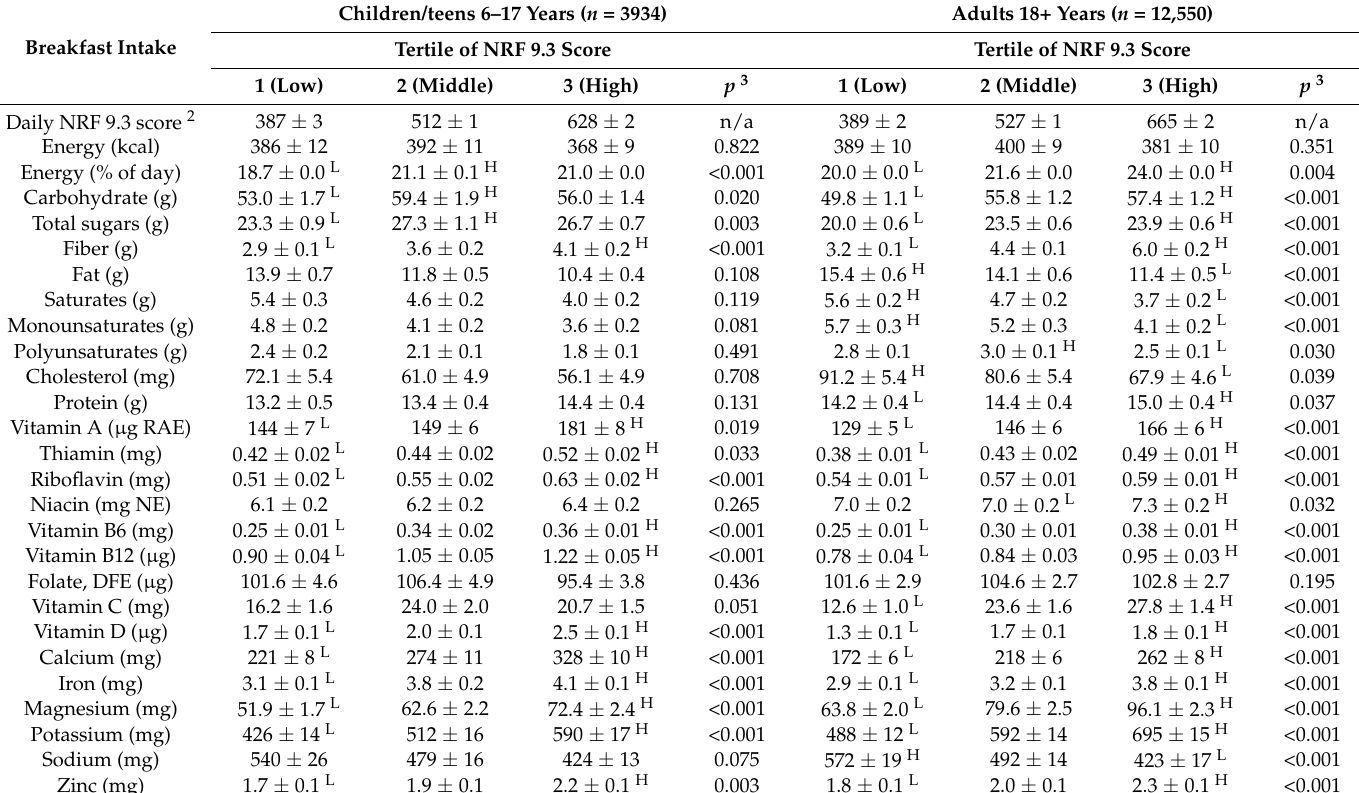
Table 4. Breakfast energy and nutrient intakes of Canadians by tertile of daily NRF Index 9.3 (NRF 9.3) score 1,2